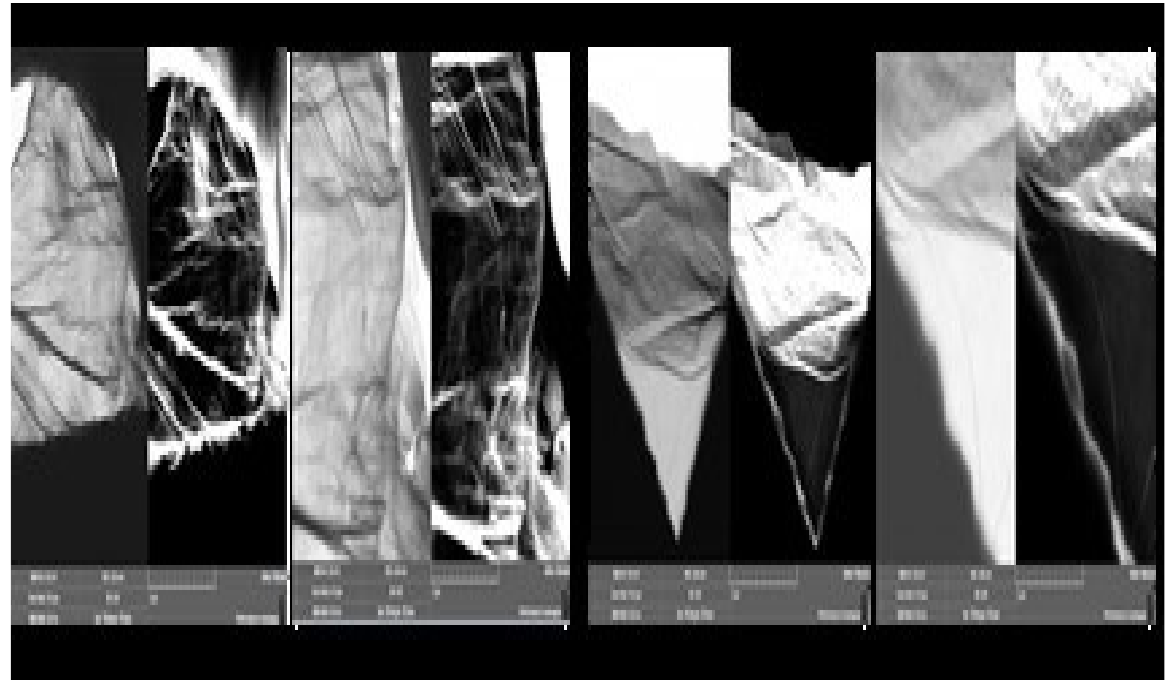
) 20.00 kx, a ) 50.00 kx magnification, Improved Hummers’ GO nanosheets at 1 2